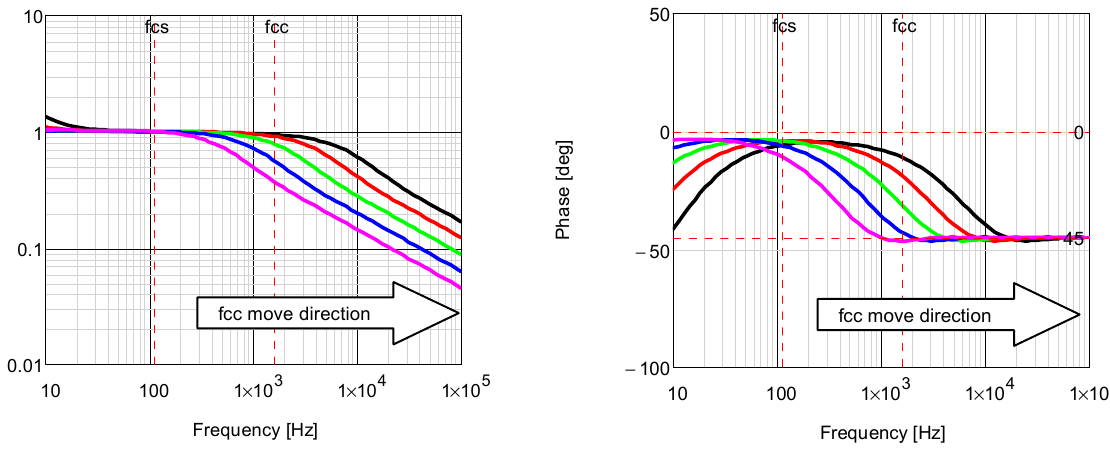
Figure 4. Theoretical PTR amplitude and phase characteristics calculated for different values of thermal parameters. Solid green line ( α c , λ c ), solid red line (2× α c , 2× λ c ), solid black line (4× α c , 4× λ c ), solid blue line ( α c /2, λ c /2) and solid pink line ( α c /4, λ c /4).